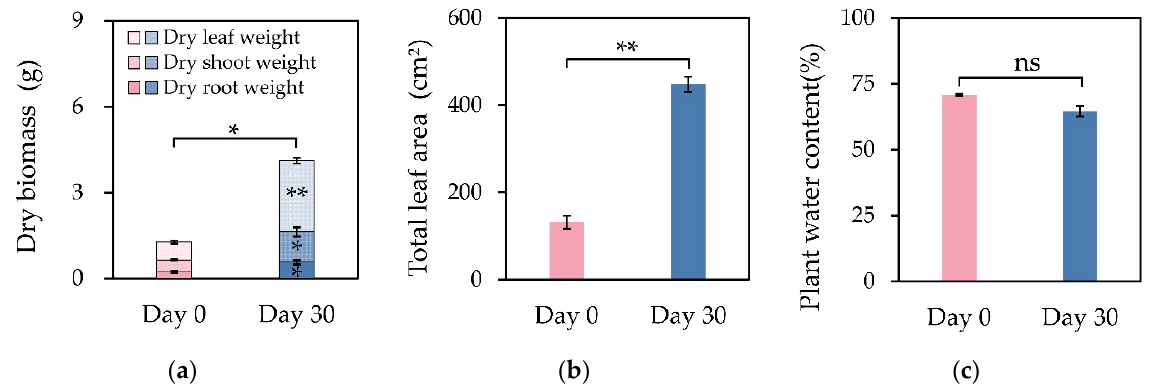
Figure 3. The plant growth characteristics of M.9 clones on Day 0 and Day 30. ( a ) Root, shoot, leaf, and total dry mass; ( b ) total leaf area; ( c ) plant water content. Total leaf area was measured before drying. Columns are the means of data ( n = 3) ± standard error (SE) bars. The ‘*’ and ‘**’ presented in a column in ( a ) represent the significance levels of the growth of different tissues measured on Day 0 and Day 30. The ‘ns’ indicated significance levels with p ≥ 0.05.